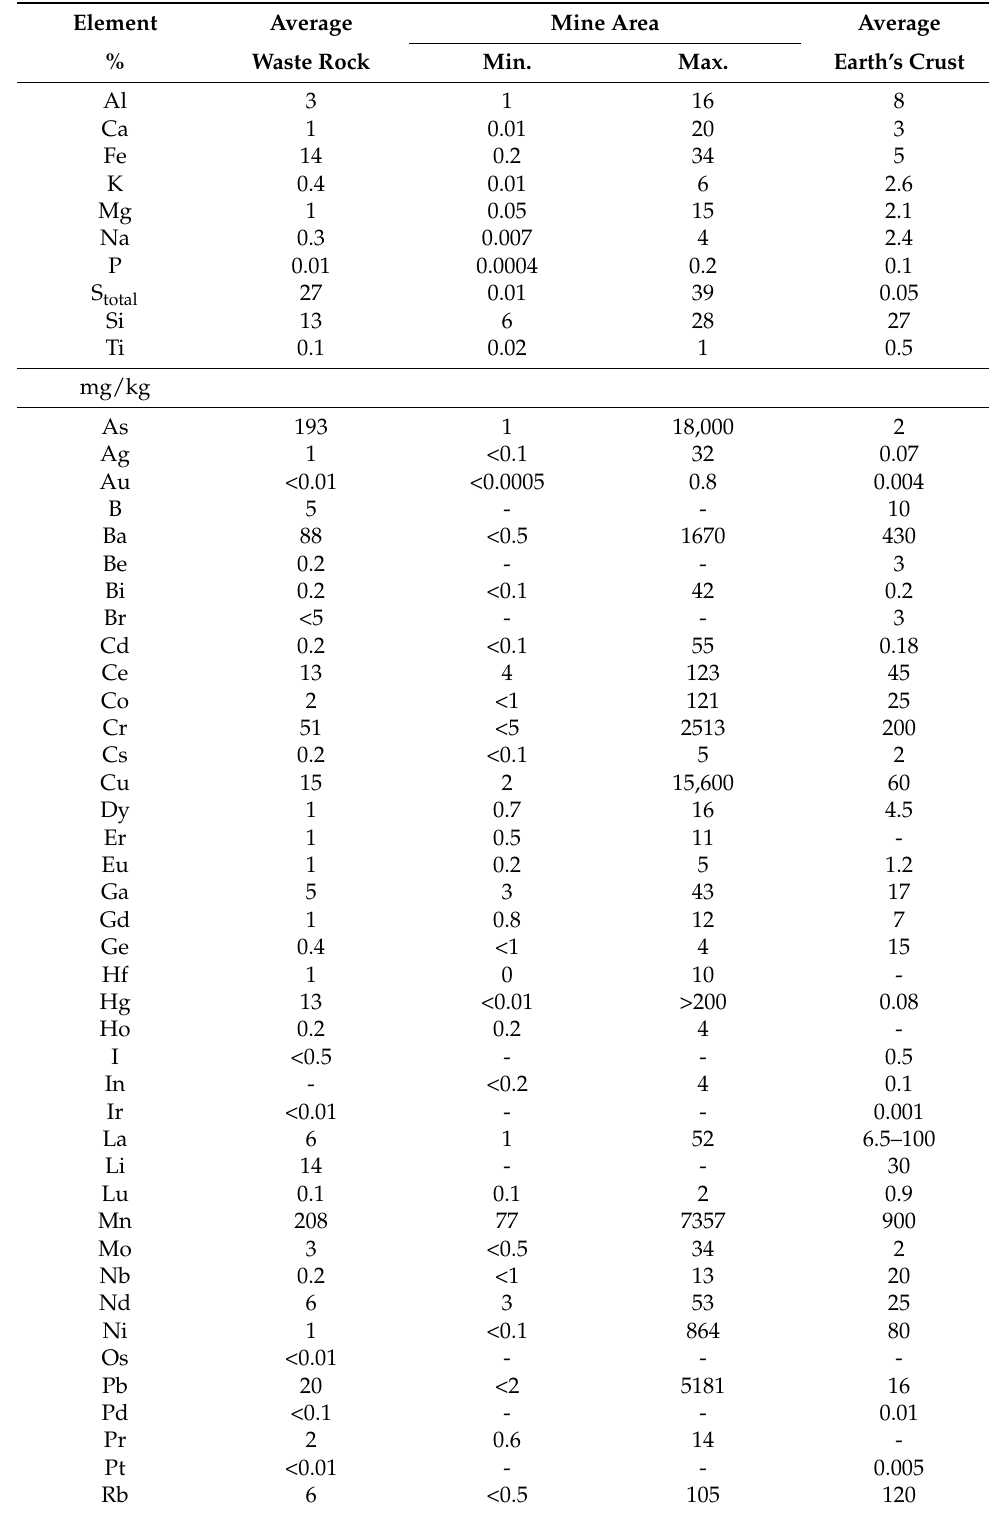
Table 3. Abundance of selected elements in the sulfidic waste rock. The waste rock is presented as the average of screening and results reported by Alakangas et al. [7] and Nyström et al. [5]. The waste rock is compared to minimum and maximum concentrations of rock (mainly ore) sampled in the area and average content in the average earth’s crust